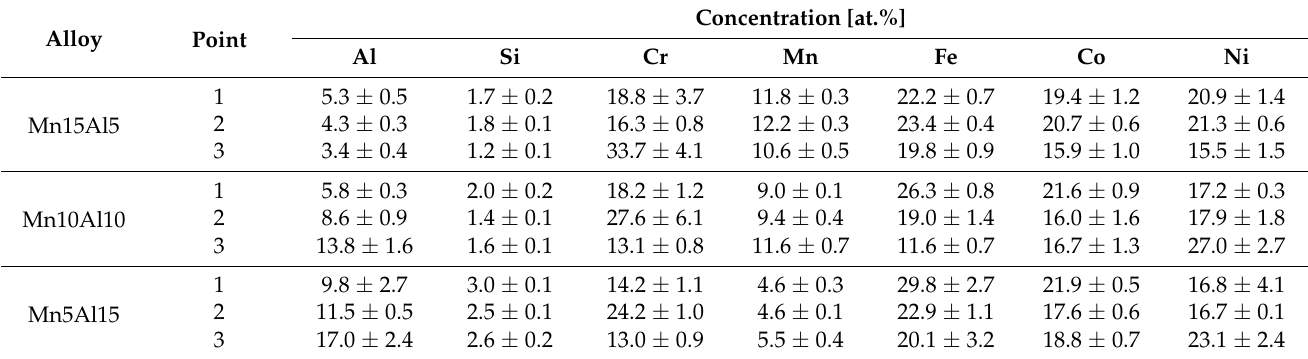
Table 7. SEM + EDS analysis of the chemical composition of points marked in Figure 12.